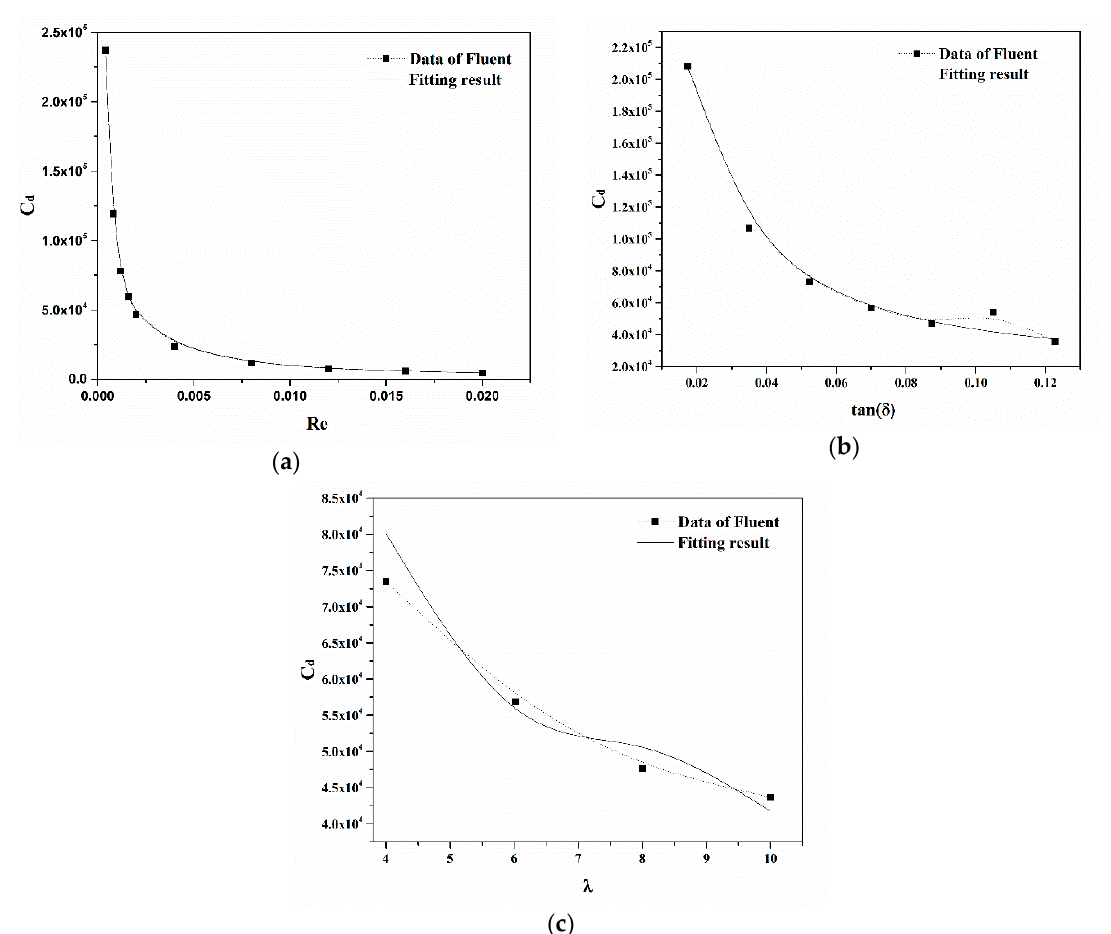
Figure 7. The numerical fitting results of the drag coefficient C d versus ( a ) Re , ( b ) δ and ( c ) λ .